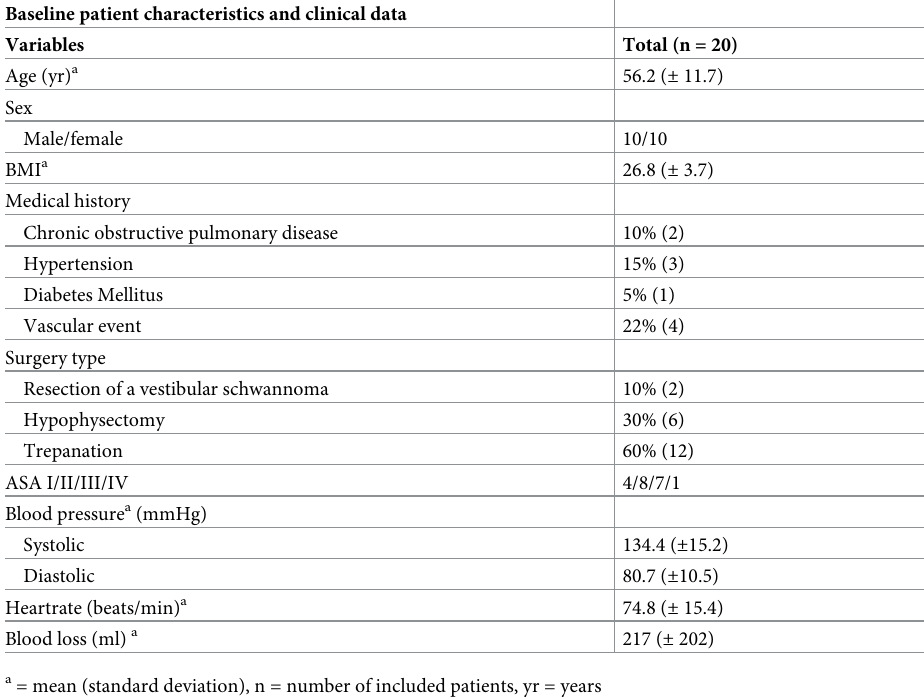
Table 1. Baseline patient characteristics and clinical